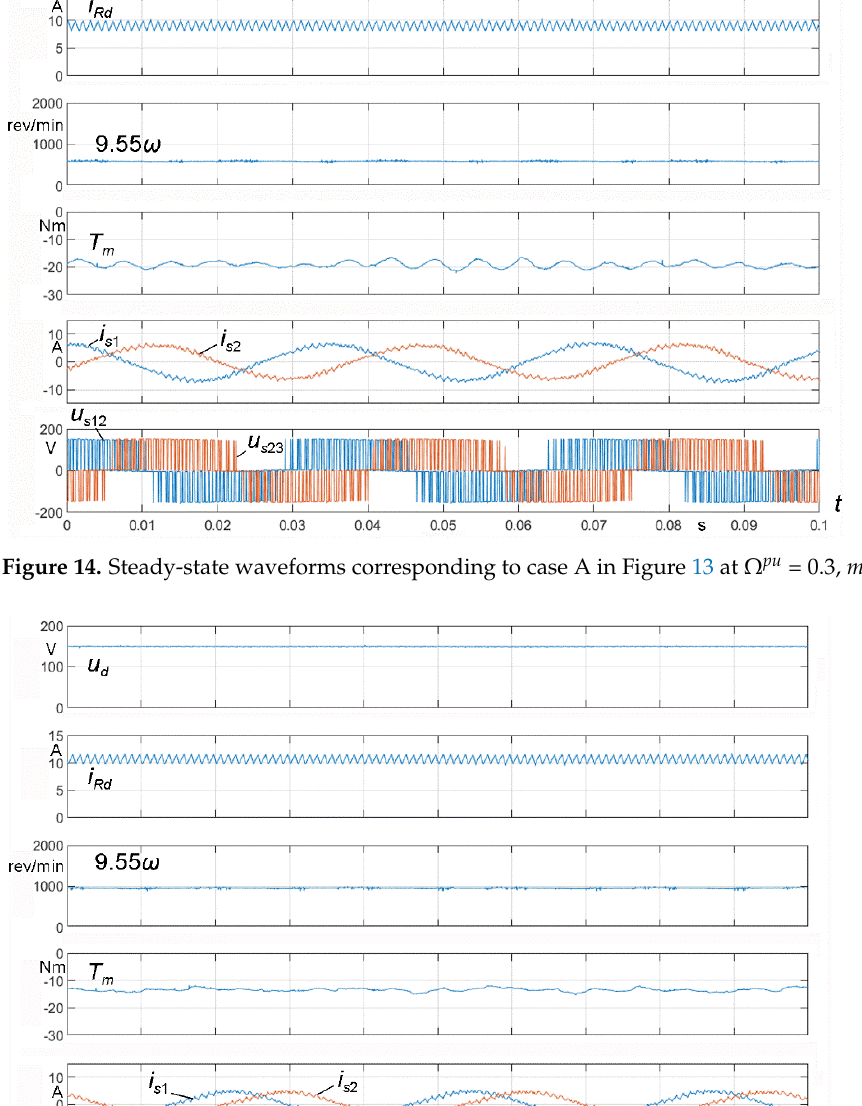
Figure 15. Steady-state waveforms corresponding to case B in Figure 13 at Ω pu = 0.48, m = 2.